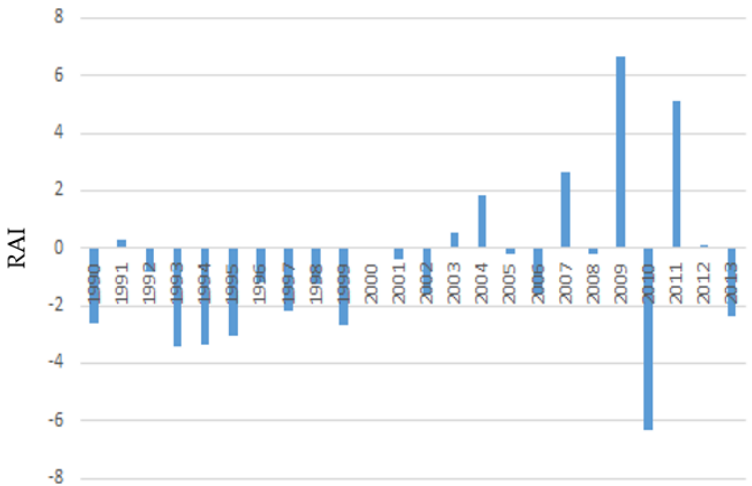
Figure 3. Rainfall anomaly index (RAI) for the Giresun province.